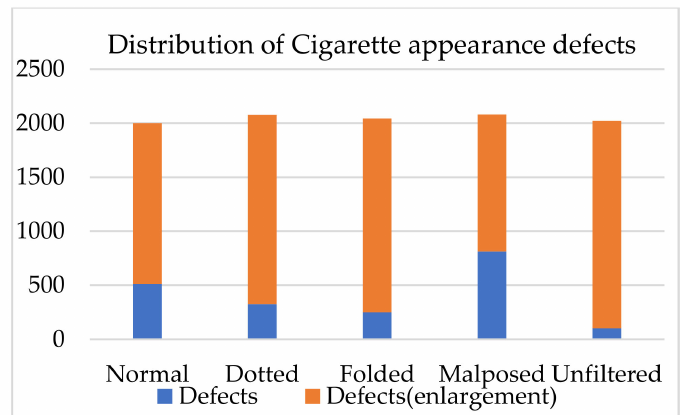
Figure 9. Distribution diagram of cigarette appearance data set.